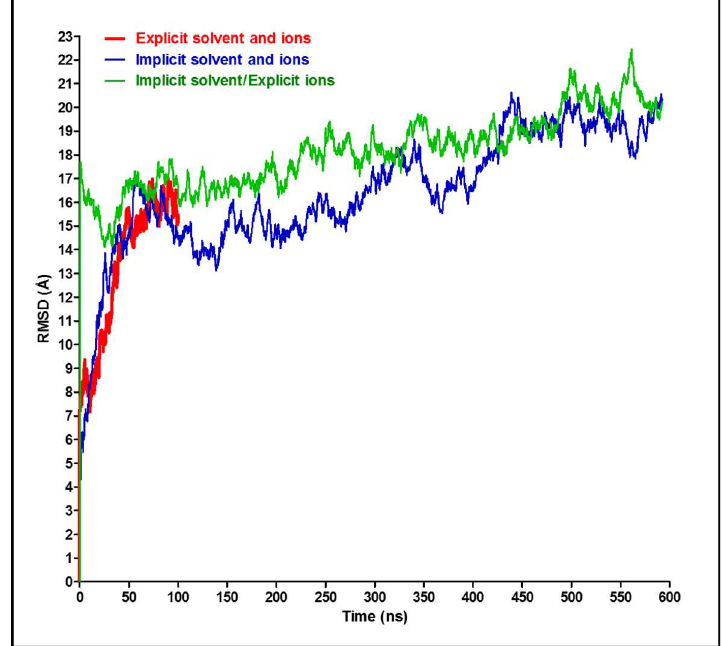
Figure 7. RMSD extrapolation between implicit and explicit systems. Time values were corrected for the implicit system through multiplying by a conversion factor of 6.